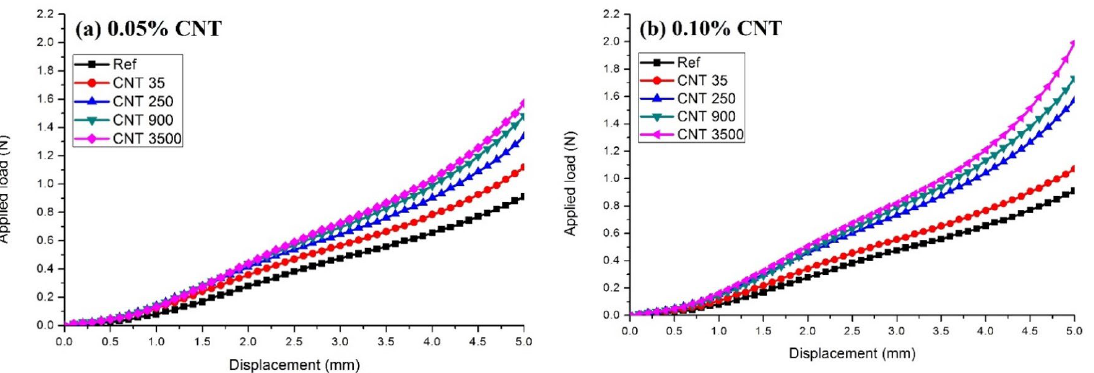
Figure 1. Squeeze flow test curves (applied load vs. displacement) of the pastes. (a) 0.05% CNT; (b) 0.10% CNT.